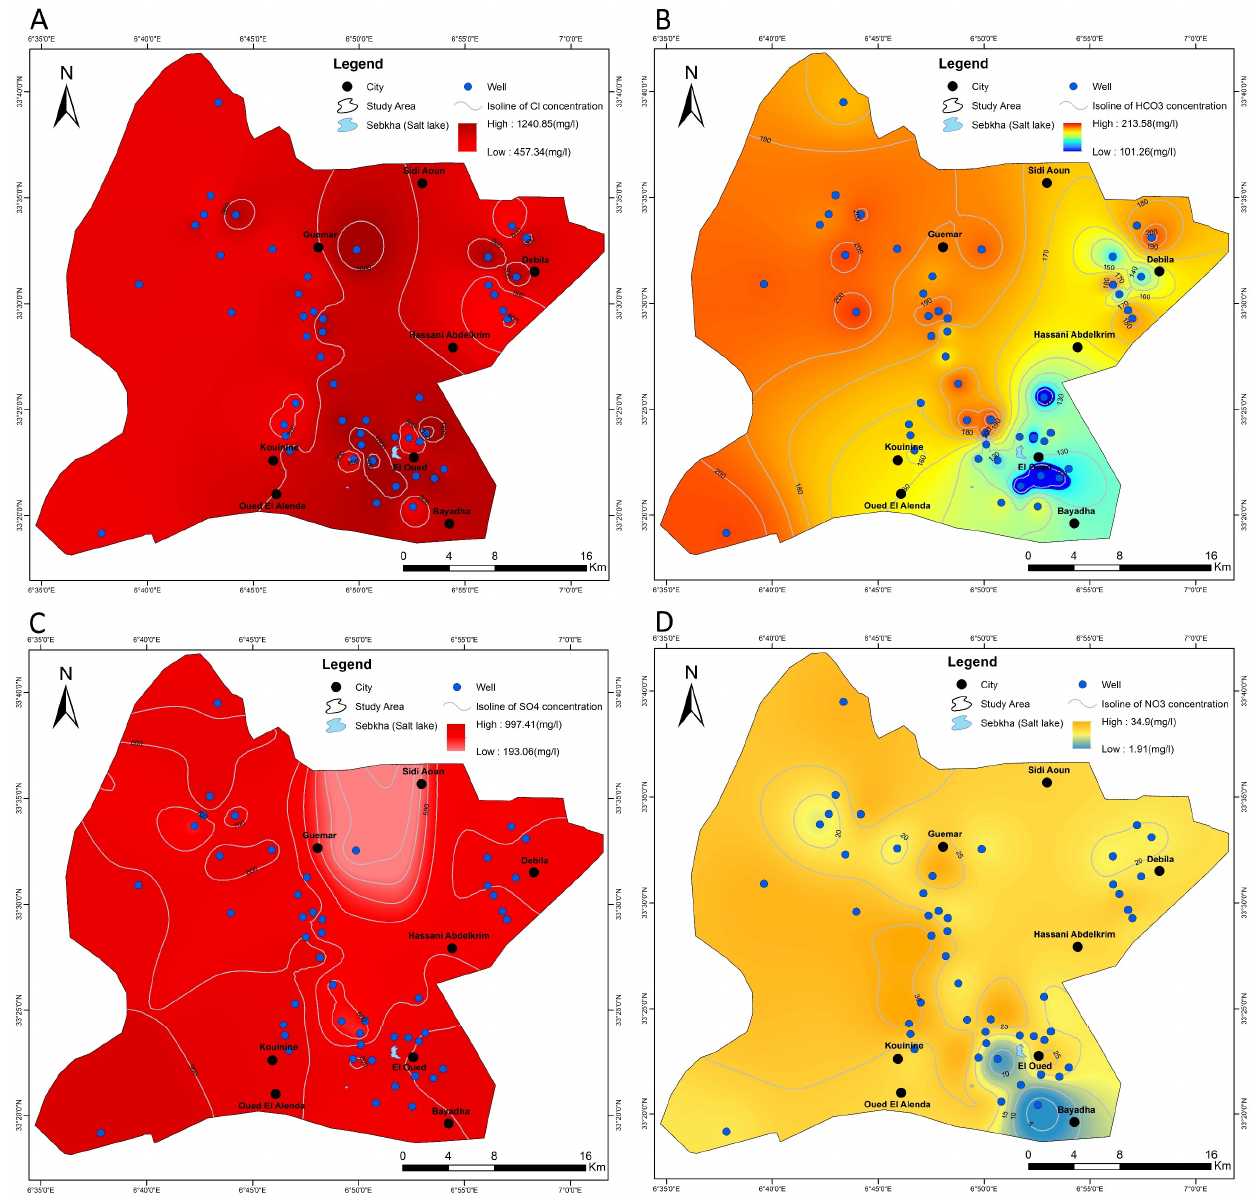
Figure 9. Spatial distribution of anions: ( A ) Cl − , ( B ) HCO 3 − , ( C ) SO 42 − , ( D ) NO 3 − . Potassium comes mainly from evaporites, in this case, sylvite (KCl), or as a result of an alteration of potassium clays in the phreatic and complex terminal aquifer. The study area is characterized by high values of potassium, except for some zones where the potassium concentrations are very low, such as Debila, Guemar, and El Oued, as shown in Figure 8D. Nitrate mainly comes from the contamination of wastewater in urban areas and fertilizers in agricultural lands. Figure 9D reveals that the high values of nitrates are found in the northwest and west of the study area, north of Guemar, north of Kouinine, and east and north of El Oued. The high values of nitrates confirm the dilution between the phreatic groundwaters and the complex terminal flows, resulting in considerable amounts of nitrates in the complex terminal waters. The low values are registered in the ghouts covered with reeds because of their use for the growth of reeds and at the level of the release of El Oued, where the oxygen necessary for the respiration of microorganisms is provided by the denitrification of